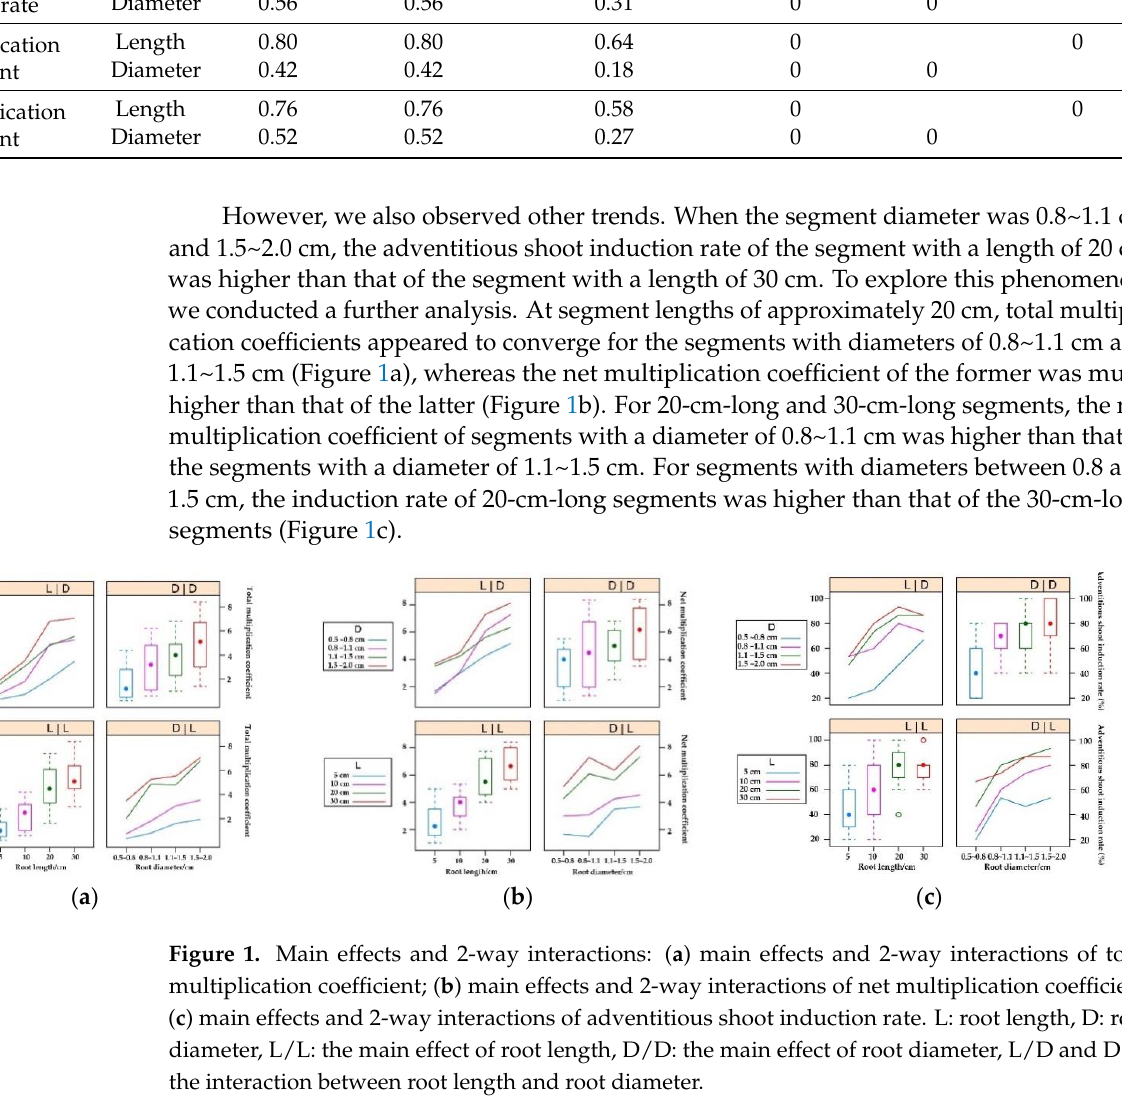
Table 3. Path analysis of roots ’ length and roots ’ diameter in root budding.